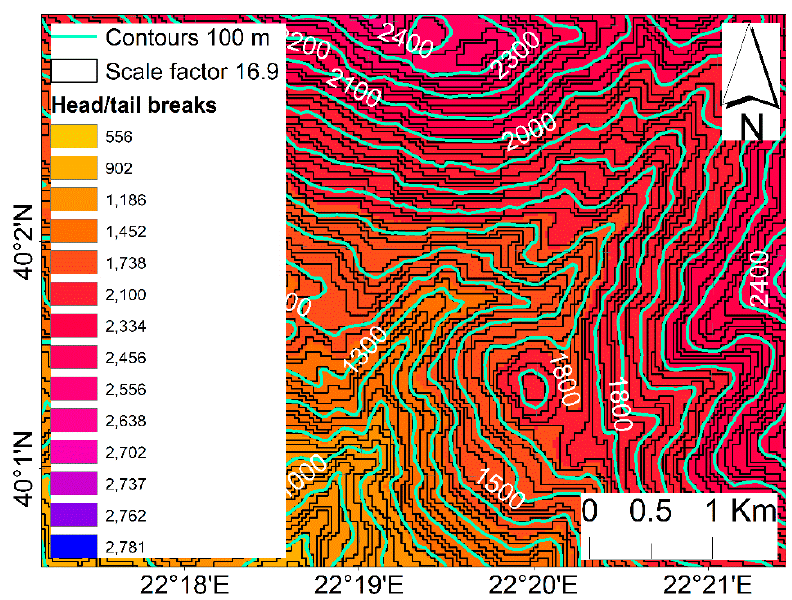
Figure 8. An indicative abstract from the segmentation results of Pinios elevation case; 100-m contour lines and the elevation values reclassified with the head/tail breaks are overlaid for comparison.